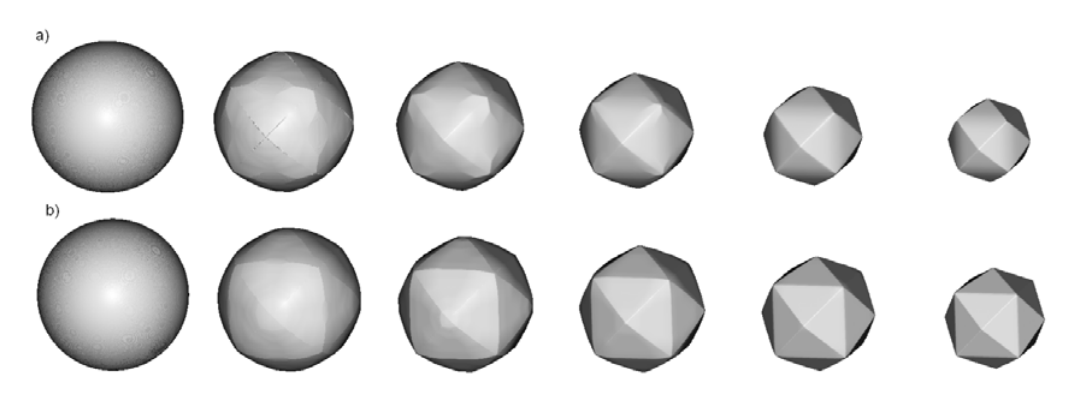
Figure 6. Etching profiles of the sphere with initial radius of 25  m after 0 s, 100 s, 200 s, 300 s, 400 s, 500 s and 600 s, obtained using thirteen-parameters interpolation formulas for (a) 40% and (b) 50% etchant concentrations.